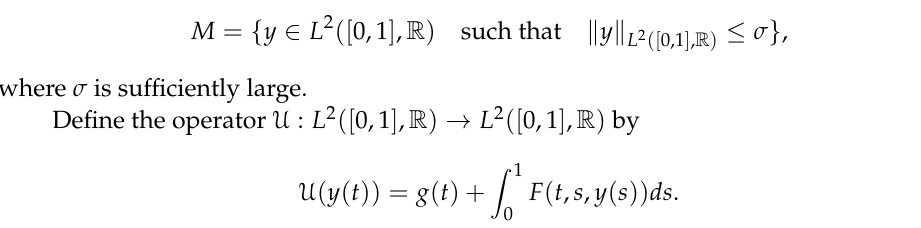
(cid:113) n + 1 , 5 n + 1